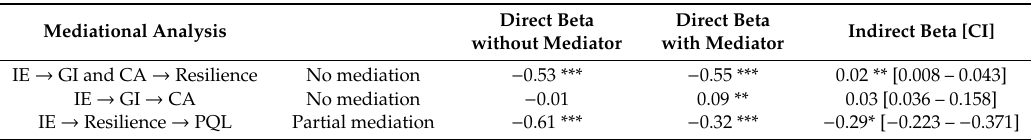
Table 2. Results of mediational